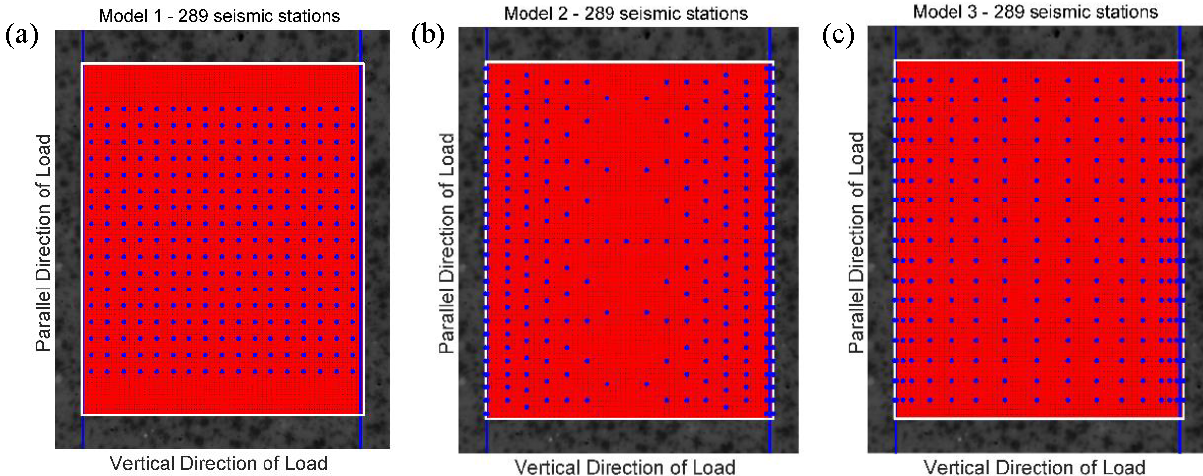
Figure 6. Three kinds of seismic monitoring models with different numbers of seismic monitoring stations. Each figure shows the obser- vational area of sample 4. The blue lines indicate the prefabricated cracks. The area enclosed by the white rectangle is the calculation area. The red points in the calculation area represent all the sampling points, while the blue points indicate the limited sampling points (seismic monitoring station) in different models. The horizontal axis is perpendicular to the direction of load, and the vertical axis is parallel to the direction of loading. (a) Model 1 with 289 seismic stations. (b) Model 2 with 289 seismic stations. (c) Model 3 with 289 seismic stations.